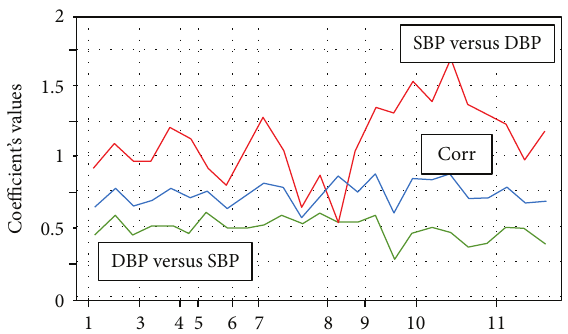
Figure 5: Interdependence of systolic and diastolic blood pressure at different stages of heart failure treatment and cardiac